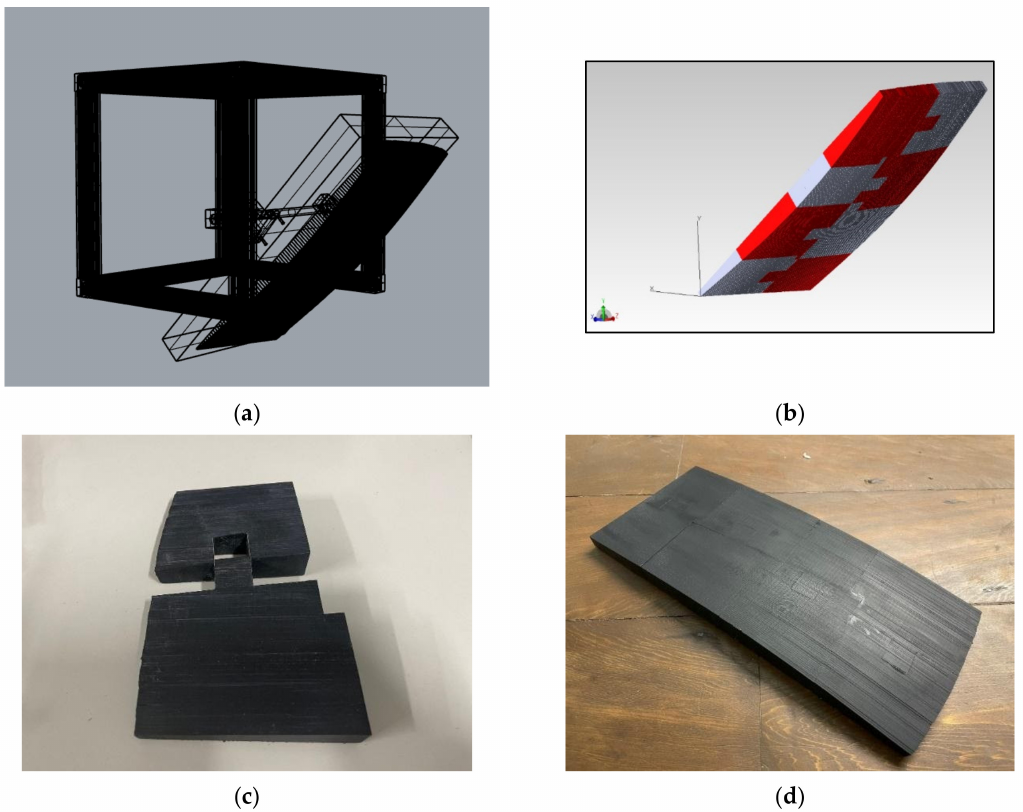
Figure 18. ( a ) Module simulation shown in CAD software; ( b ) freeform reflector divided into eight pieces; ( c ) parts of the freeform mirror before coating; and ( d ) glued freeform surface before